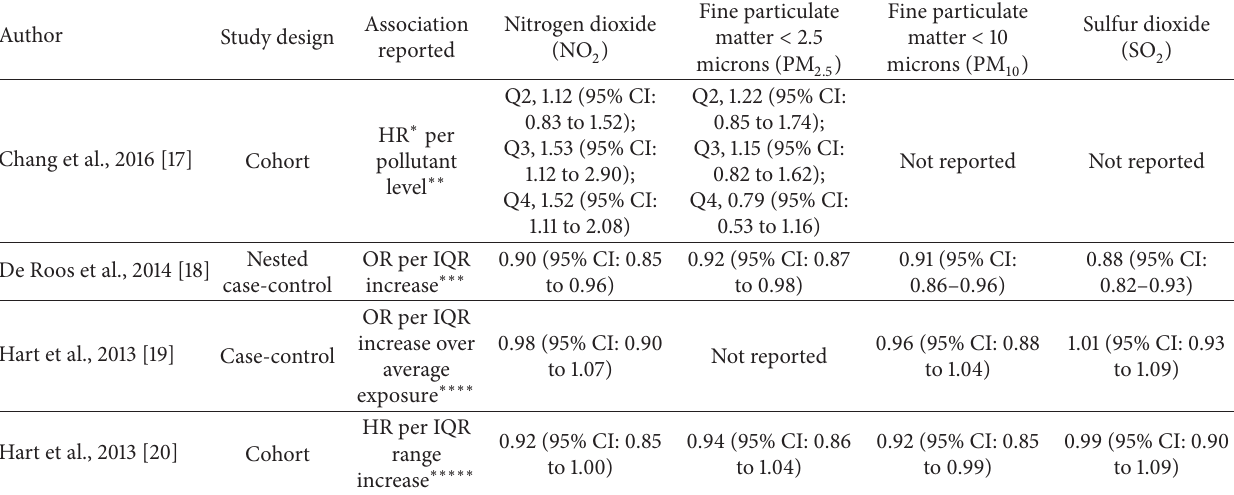
Table 2: Association between air pollutant exposure and the development of rheumatoid